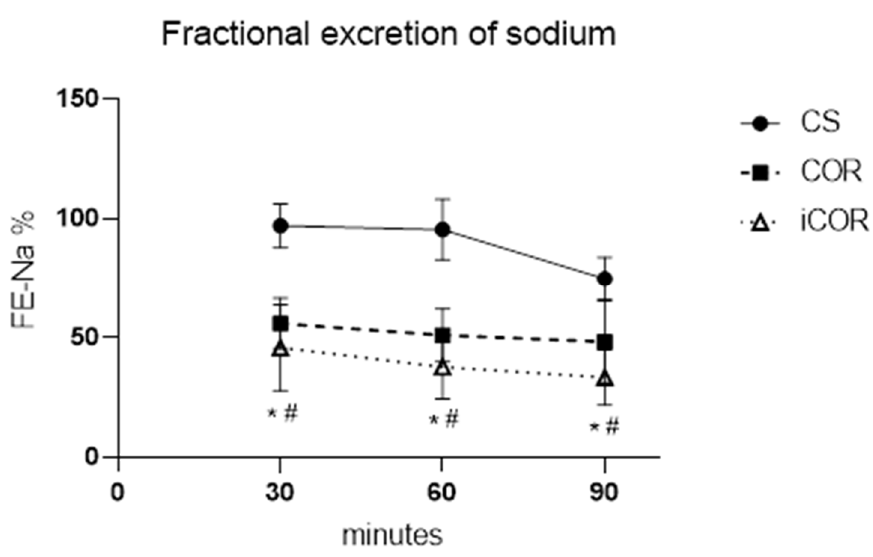
Figure 3. Course of fractional excretion of sodium (FENa) during isolated reperfusion in vitro after 20 h cold storage (CS) or after 2 h of subsequent controlled oxygenated rewarming with (COR) or without (iCOR) an initial hypothermic perfusion period (*: p < 0.05 COR vs. CS; #: p < 0.05 iCOR vs. CS).